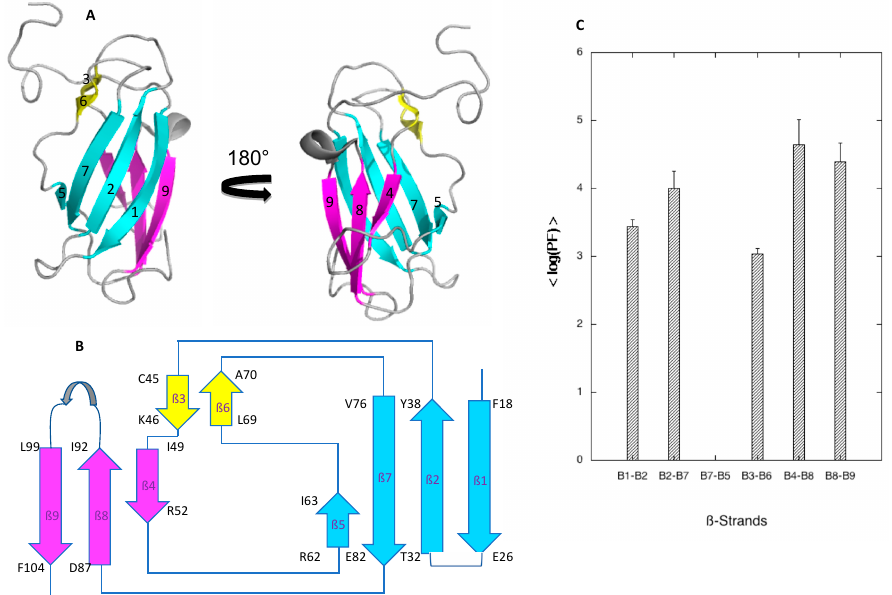
Figure 3. Structure and local stability of DEN4-ED3. ( A ) Ribbon representation of the solution structure of DEN4 (Volk et al. [15]). The cyan and magenta colors have been used for the two ß-sheets that form the ß-sandwich. Note the presence of an extra small double-stranded ß-sheet that does not contribute to the structure of the ß-sandwich. ( B ) Topology diagram of DEN4-ED3. The same colors as in ( A ) have been used for the different ß-sheets. ( C ) Average protection factor (<PF>) values calculated for amide protection factors stabilizing each ß-sheet in the ß-sandwich.